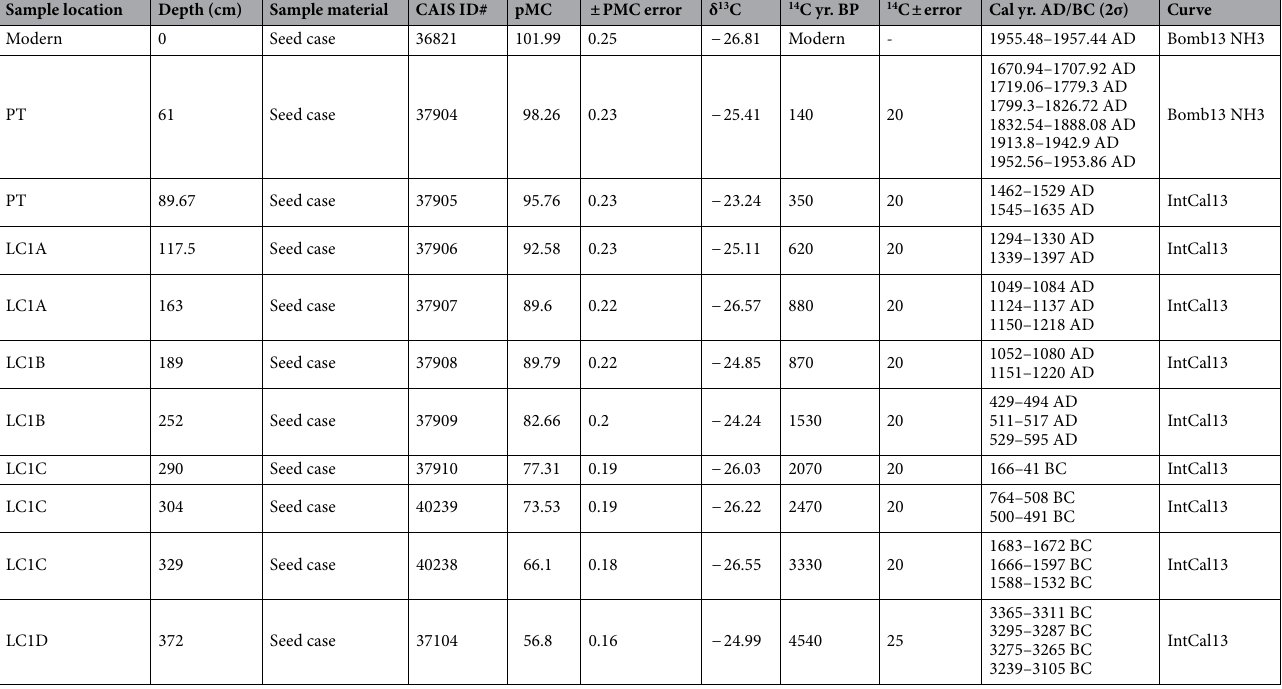
Table 1. Radiocarbon dates from Deoria Tal. All samples calibrated using OxCal 4.3 55 with the ages reported using the 2σ range derived from Reimer et al. 56